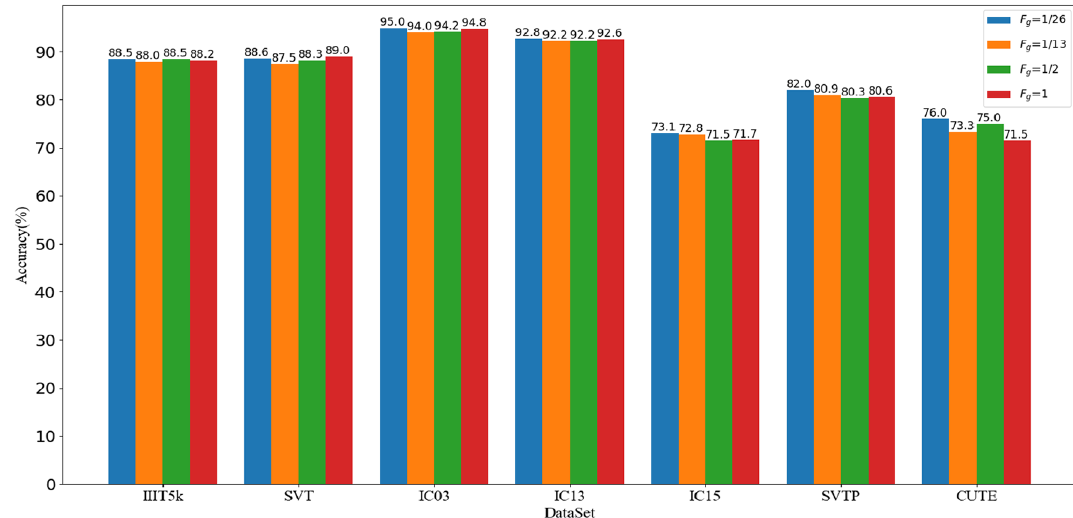
Fig. 9 Comparison of loss curves of five models on training set (the curves are shown enlarged for 220,000 to 300,000 iterations)